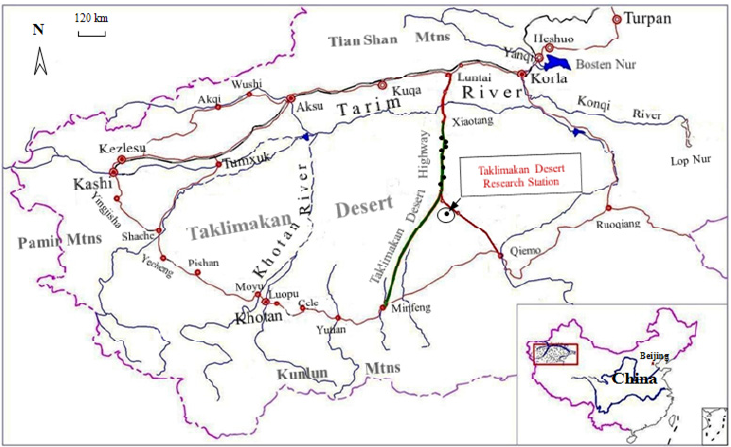
Figure 1. Taklimakan Desert Highway Shelterbelt and the sampling locations [3]. The green line indicates the Taklimakan Desert Highway Shelterbelt, and the black dots represent the sampling locations.